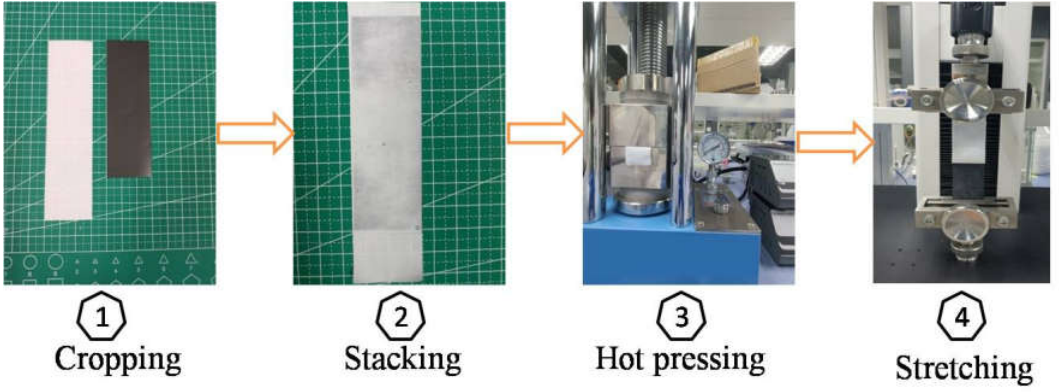
Figure 2. The adhesion test between battery separator and battery pole piece.